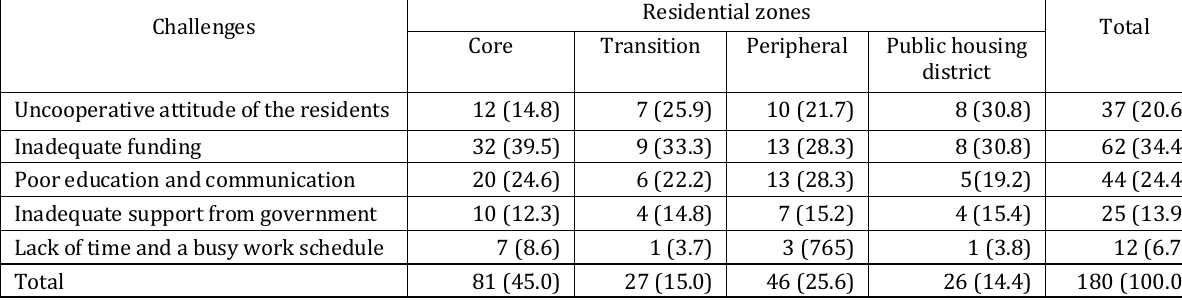
Table 11. Challenges to community participation in environmental sanitation